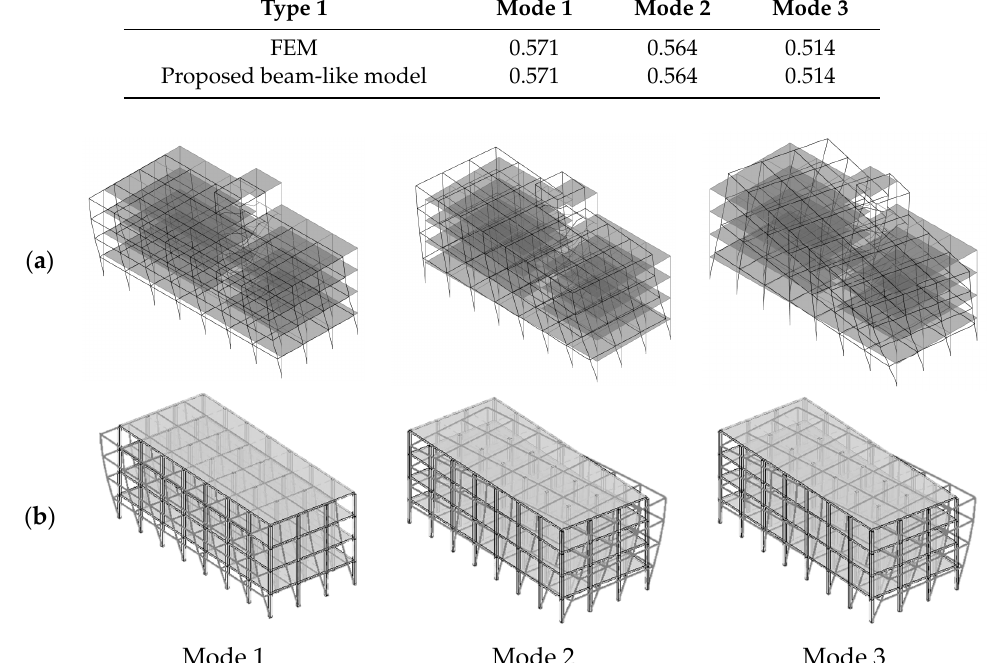
Figure 7. Four-storey benchmark. Modal shapes comparison between the ( a ) FEM and ( b ) beam-like models.